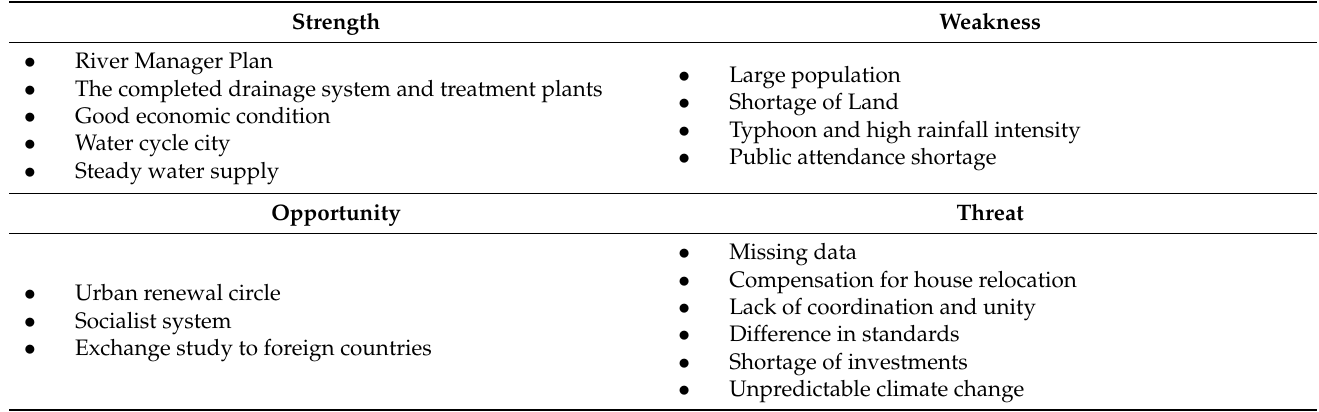
Table 1. SWOT analysis of the current condition in Guangzhou for Sponge City construction.